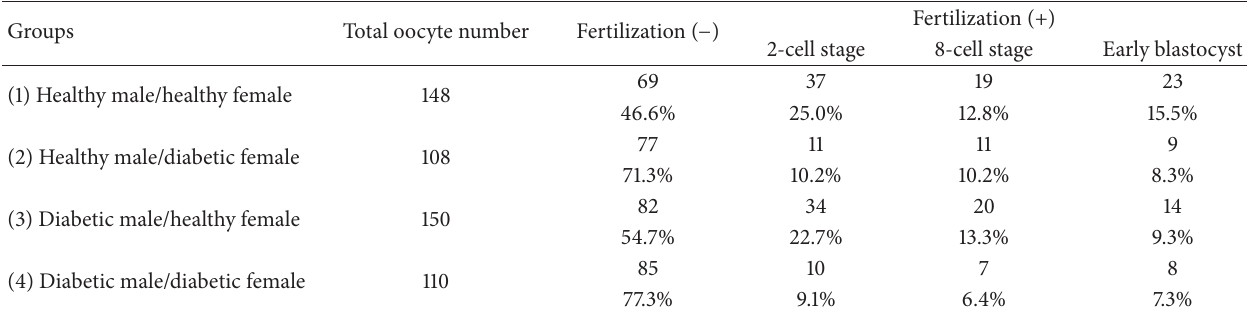
Table 3: Comparison of the in vitro fertilization success rates between the groups. Groups Total oocyte